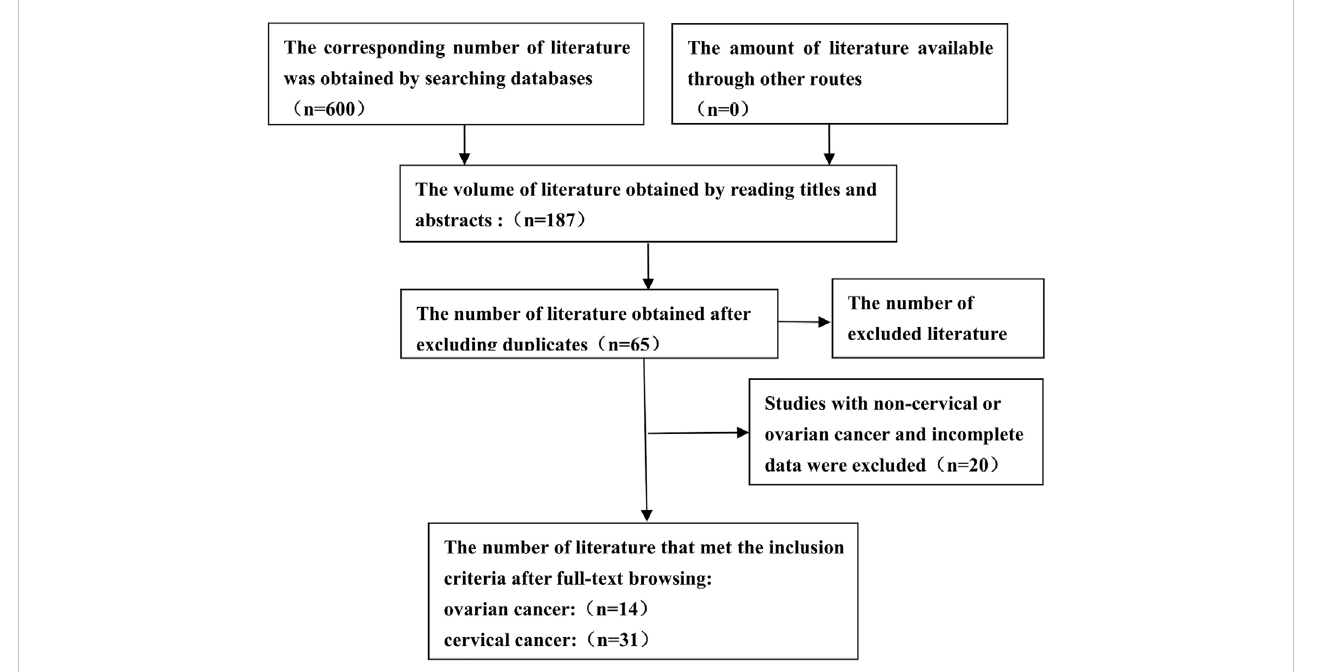
FIGURE 1 Flow diagram for identifying and including studies in the current